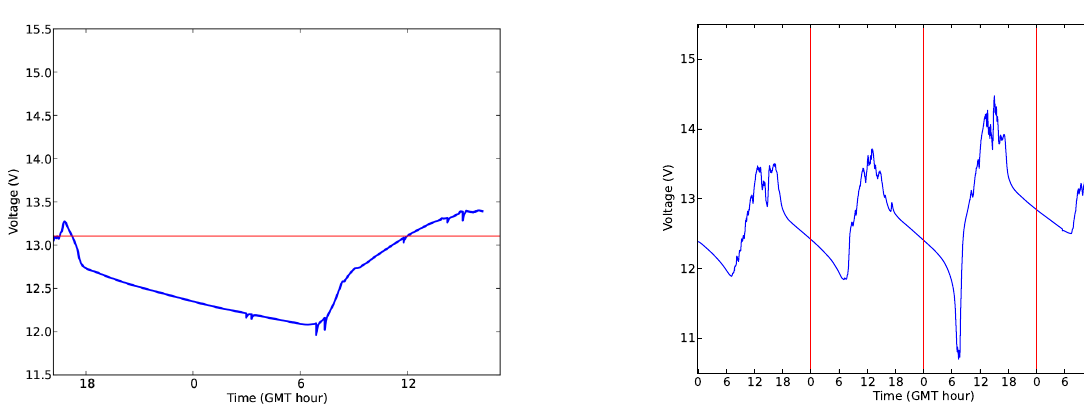
Fig. 20: Signal intensity of 4 bridge crossings